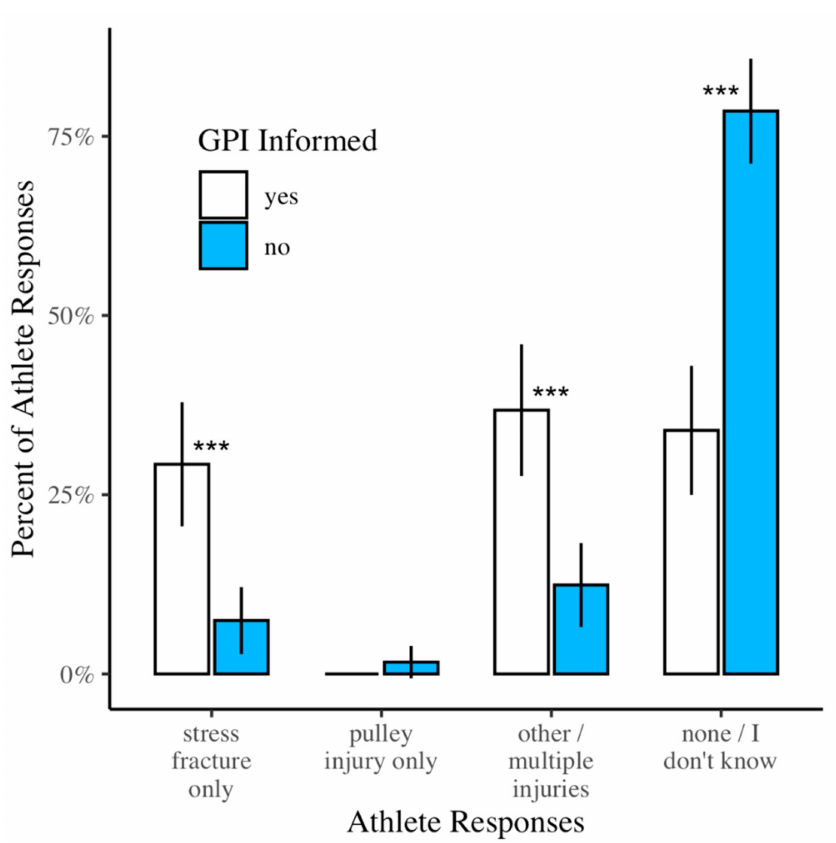
Figure 3. Athlete responses to the question “Growth plate injury to the finger is a ... ” Statistically significant comparisons between GPI informed and GPI uninformed are indicated by three asterisks ( p <